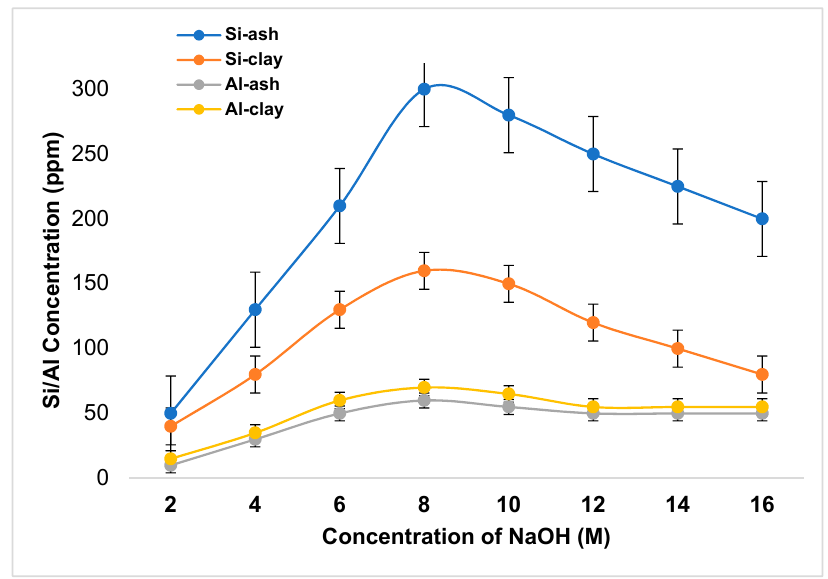
Figure 3. Effect of sodium hydroxide on the dissolution of silica and alumina.